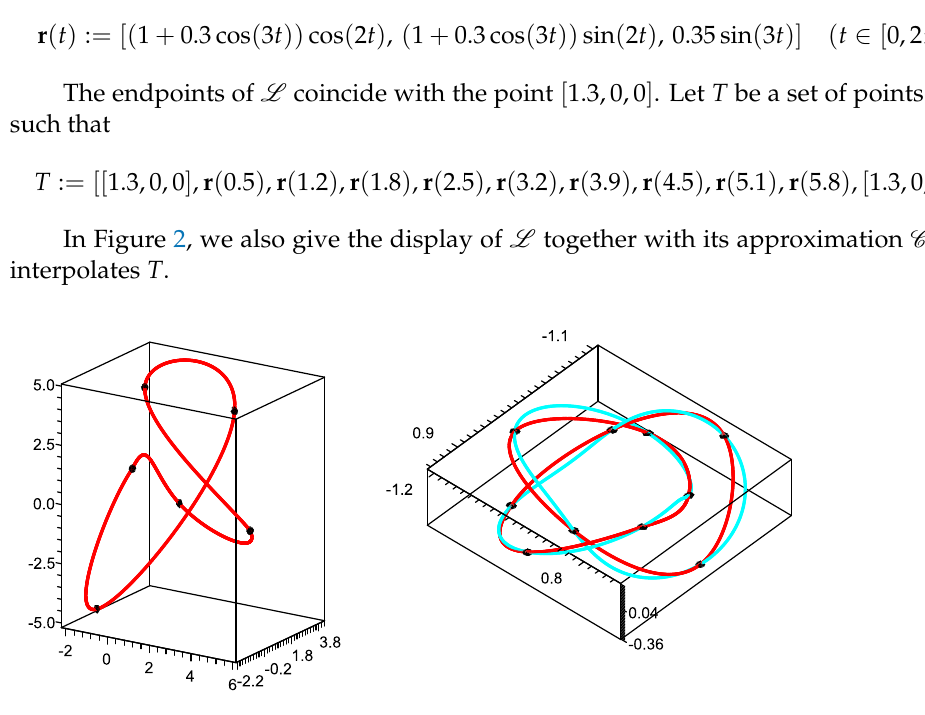
Figure 2. On the ( left ): The closed Bézier-spline curve C L interpolates the list L . On the ( right ): The closed Bézier-spline curve C T (in red) interpolates the set T of points on the curve L (in